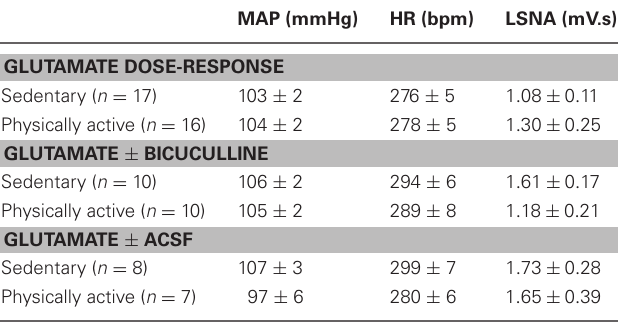
Table 2 | Baseline values for individual protocols.